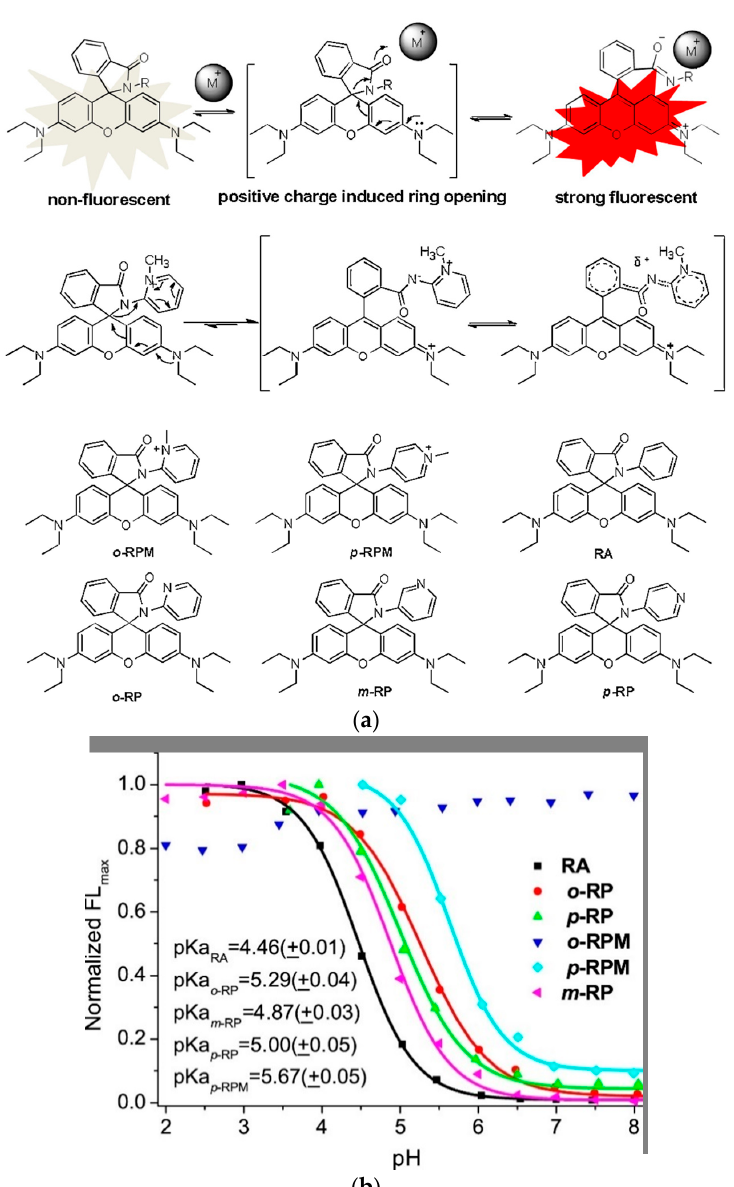
Figure 8. Acid resistant, always-on, mitochondria targeting probe: ( a ) ( top ) Metal ion induced ring-opening reaction of rhodamine spirolactam; ( middle ) Dominant structure of “always-on” rhodamine spirolactam o-RPM ; ( bottom ) Structures of o-RPM and some rhodamine control spirolactams; ( b ) Normalized intensity at emission maximum vs various pH values in aqueous solutions of o-RPM and controls. Adapted with permission from [133].